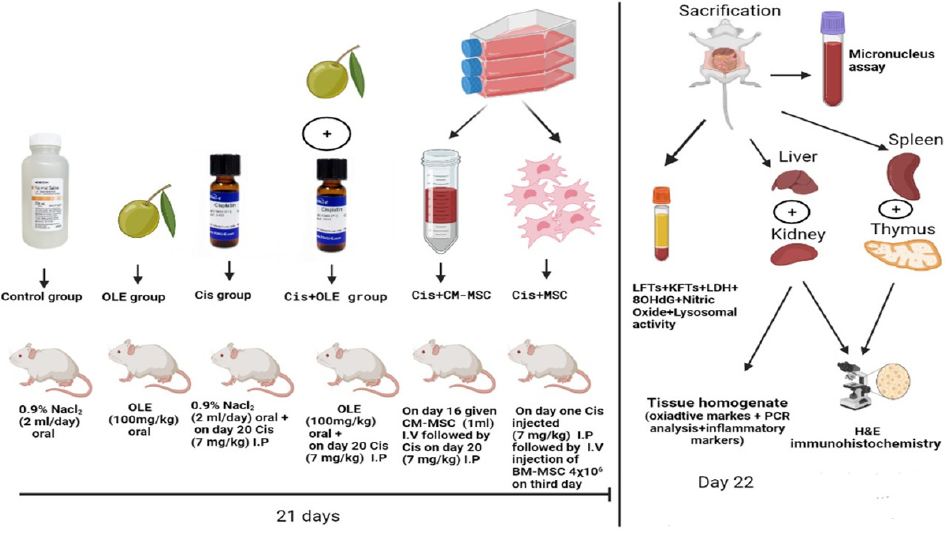
Scheme 1. A schematic diagram showing the experimental design.